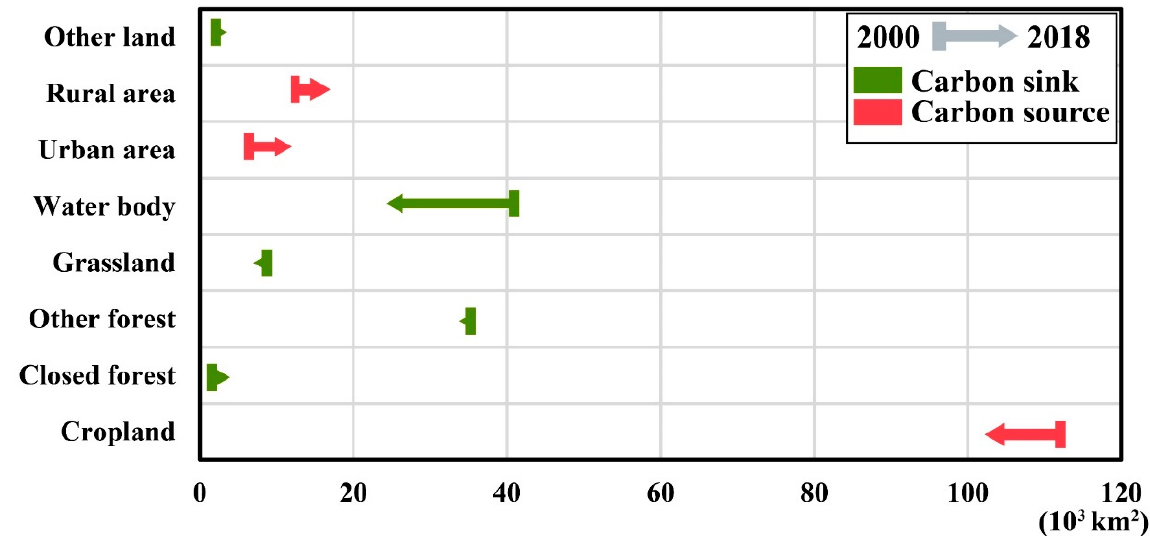
Figure 2. Land use/cover changes in Beijing–Tianjin–Hebei from 2000 to 2018.